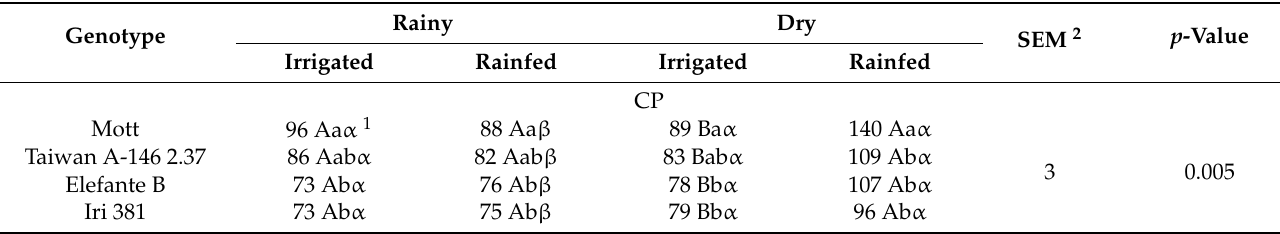
Table 4. Leaf crude protein (CP), neutral detergent fiber (NDF), acid detergent fiber (ADF), and in vitro dry matter digestibility (IVDDM) (g/kg dry matter) as affected by the interaction between irrigation, genotype, and season for elephantgrass genotypes at Garanhuns, Pernambuco,